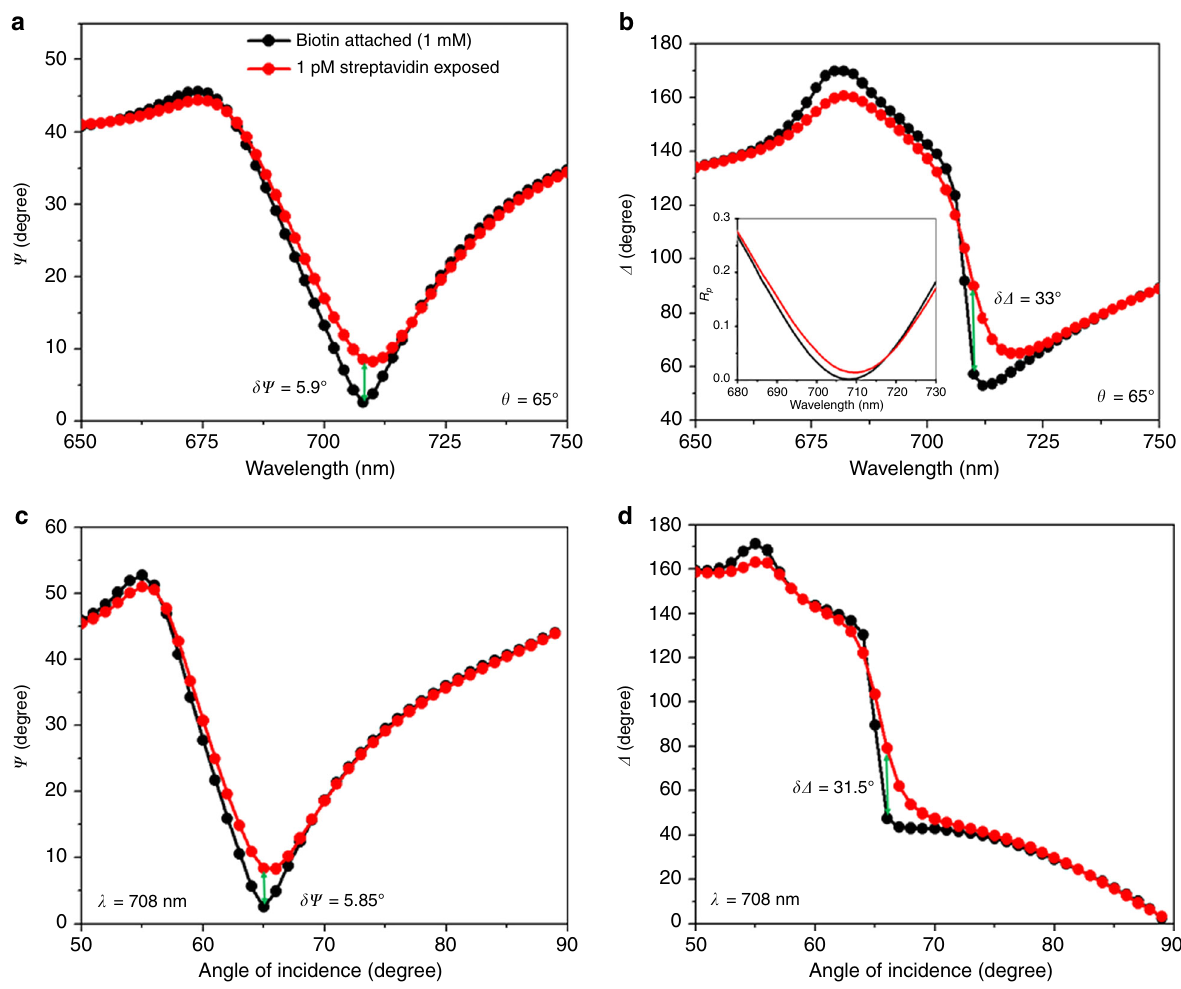
Fig. 4 Experimental biosensing. Ellipsometry parameters a ψ and b Δ versus wavelength before (black curve) and after (red curve) exposure to 1 pM streptavidin at 65°. Ellipsometry parameters c ψ and d Δ versus incident angle before (black curve) and after (red curve) exposure to 1 pM streptavidin at 708 nm. The sample surface was functionalized using 1 mM biotin-thiol in PBS. The recorded maximum phase change for the 1 pM streptavidin concentration was 33° at a 65° angle of